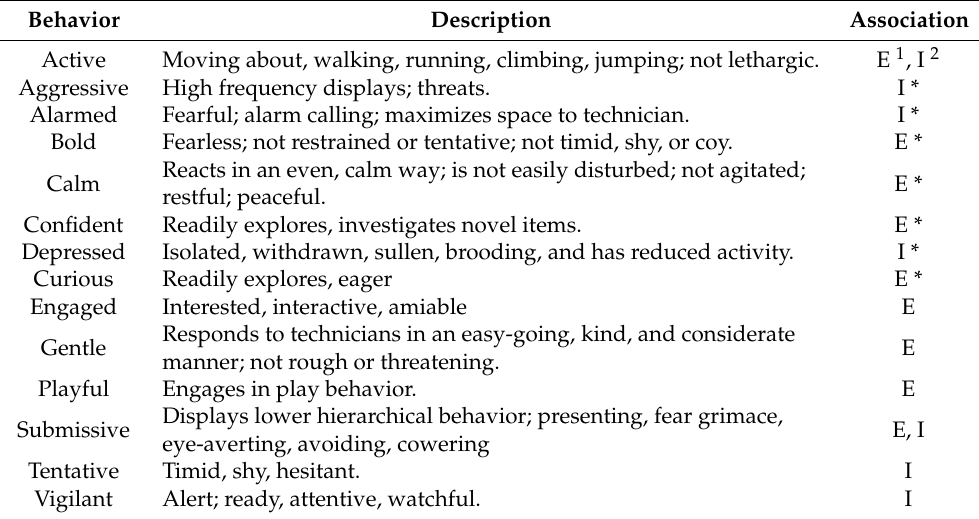
Table 1. Primate Behavioral Ethogram Used for the Classification of Primate